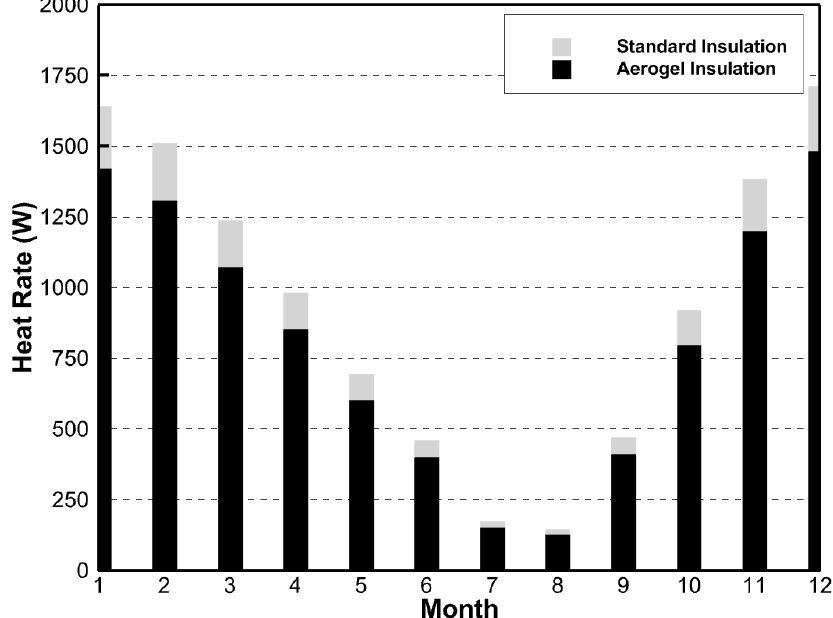
Figure 2. Simulation results of rate of heat lost through house walls comparing aerogel to standard insulation.